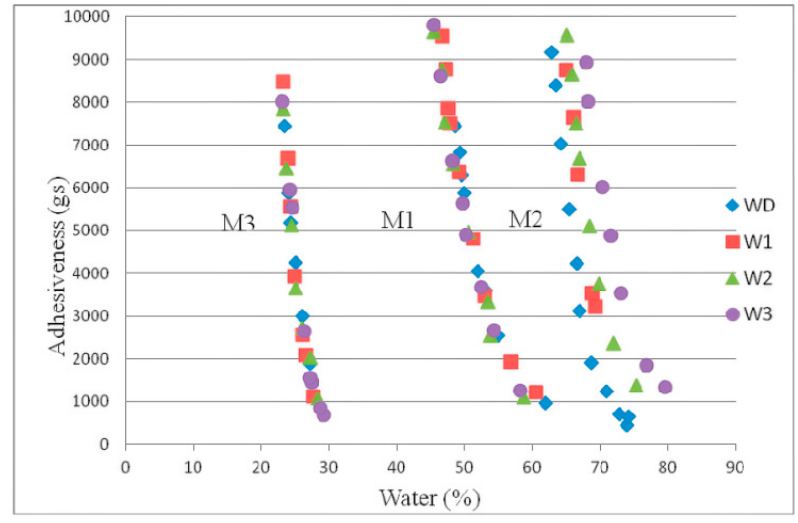
Figure 5. Adhesiveness variations with water (%) content.